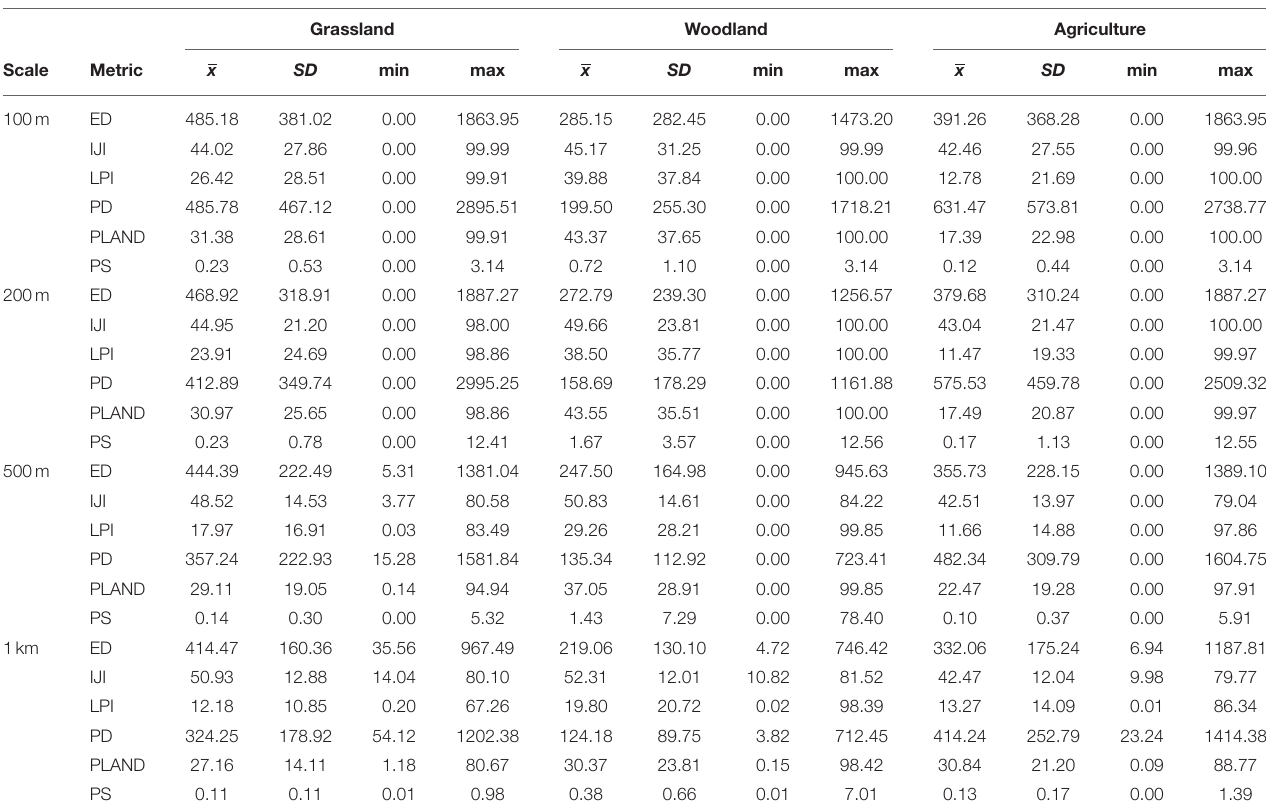
TABLE 5 | Estimates (mean, SD, and range) for six landscape-level covariates at four spatial scales calculated in each of three habitat classes for an occupancy analysis of monarchs, Iowa, 2006–2017. Grassland Woodland Agriculture Scale